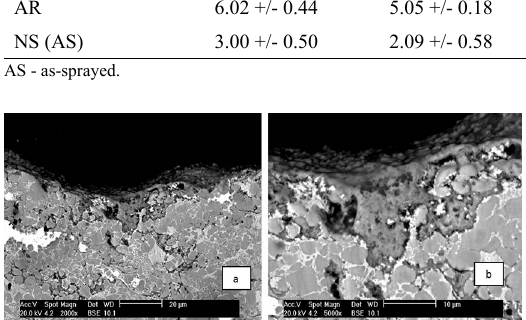
Figure 4. (a) Backscattered electron micrograph of nanostructured Cr C -25(Ni20Cr) coating E-O tested at 800ºC (19 m/s, 5 hours). 3 2 Note: the oxide layer (Cr